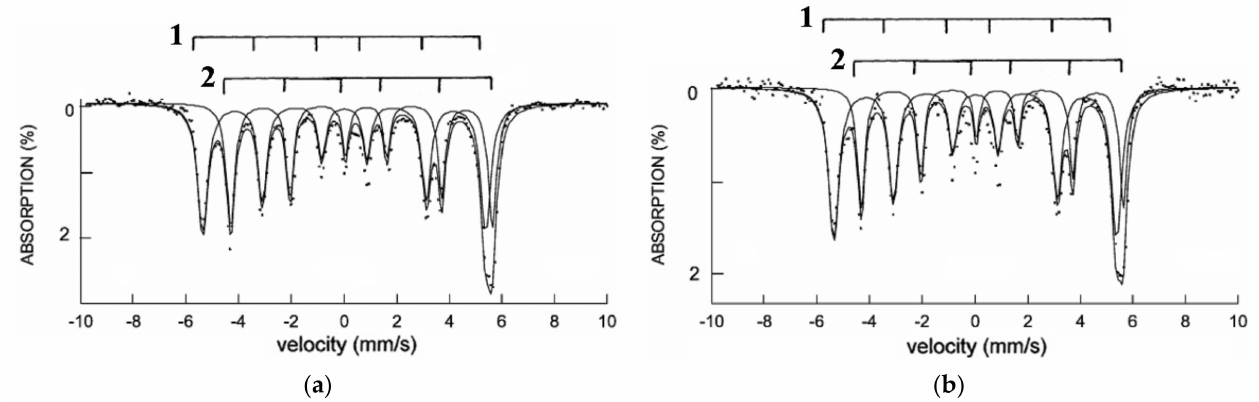
Figure 9. Room temperature Mössbauer spectra of enstatite chondrite Neuschwanstein EL6: sample Neu1 ( a ) and sample Neu2 ( b ). Spectral components are described in the text. Adapted from Reference